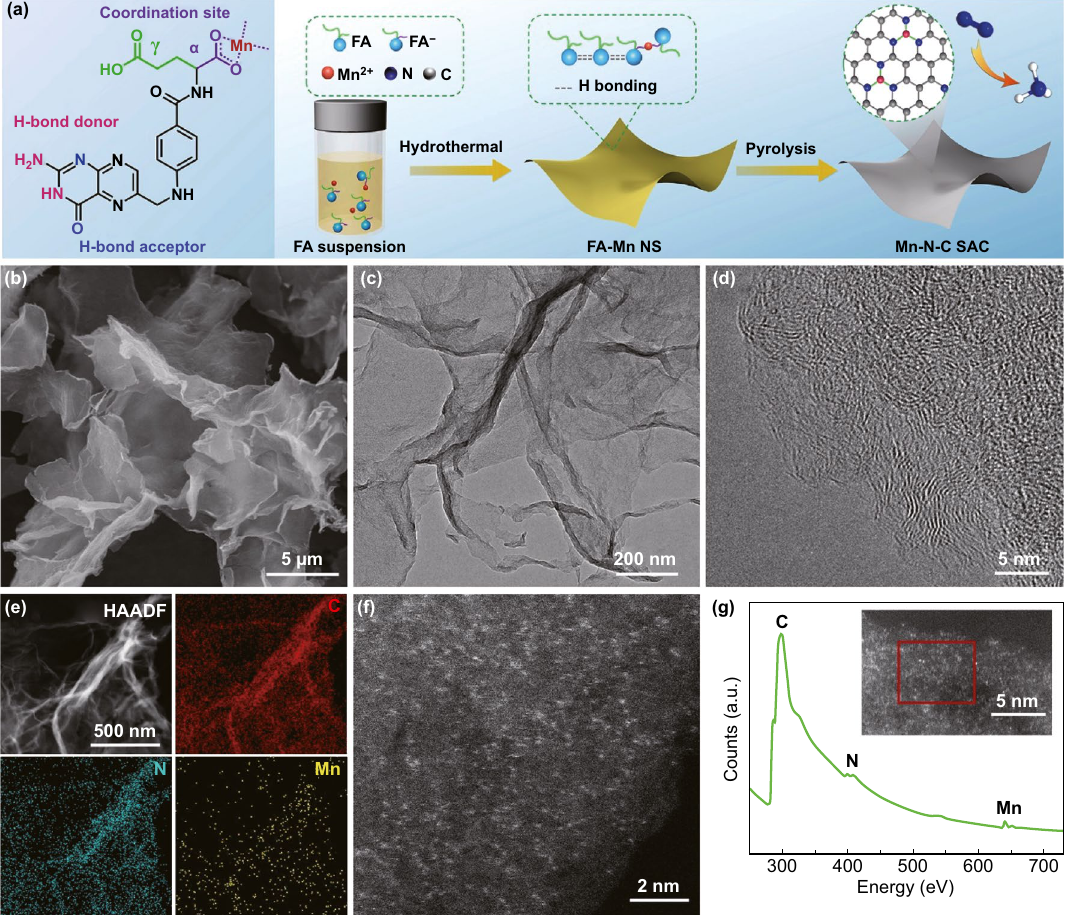
Fig. 1 a Schematic of the synthetic procedure of Mn–N–C SAC. b SEM image of FA‑Mn NS. c TEM and d bright‑field STEM images of Mn– N–C SAC. e HAADF‑STEM image of Mn–N–C SAC and the corresponding EDS elemental mapping images. f Aberration‑corrected STEM image and g the corresponding EELS curves of Mn–N–C